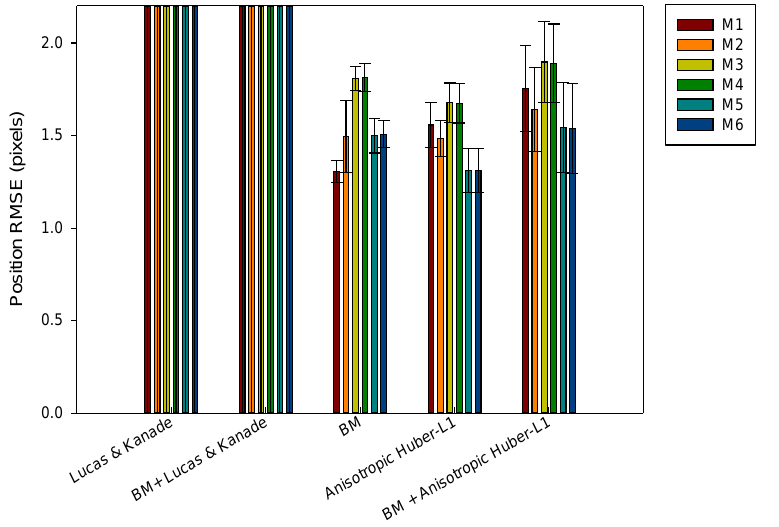
Figure 8. Position error results after being evaluated with different